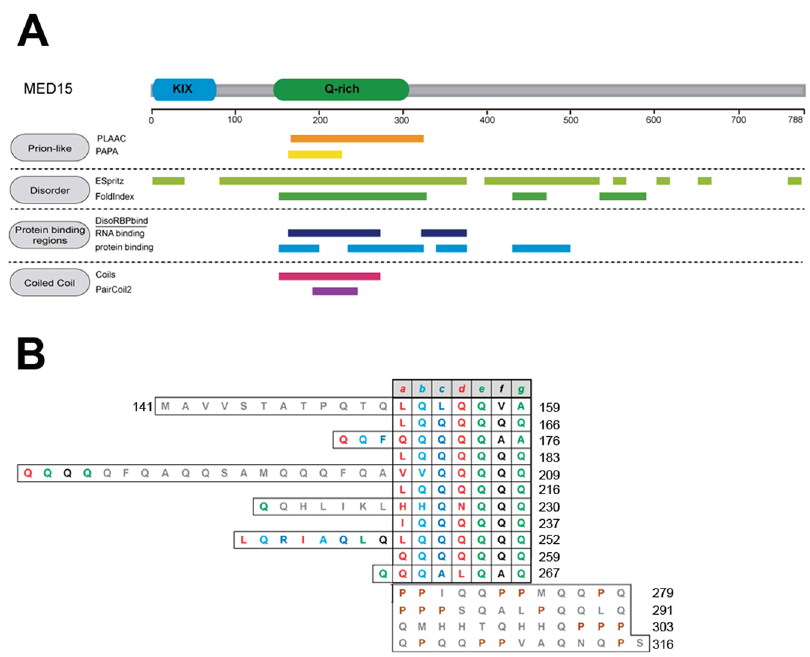
Fig. 1 MED15 contains an N-terminal Q-rich coiled-coil PrLD. A MED15 diagram showing the location of the KIX (blue) and Q-rich (green) regions. Prediction of prion-like domains using PLAAC 32 and PAPA 72 predictors, disorder regions using ESpritz 38 and FoldIndex 37 predictors, protein binding regions using DisoRBPbind 39 predictor, and coiled-coil regions using COILS 33 and PairCoil2 70 predictors are shown below the diagram. B Schematic diagram of the heptad repeats (a-b-c-d-e-f-g) predicted by COILS 33 (14-residue window) of MED15-PrLD (residues 141 – 316). Gray residues indicate COILS score